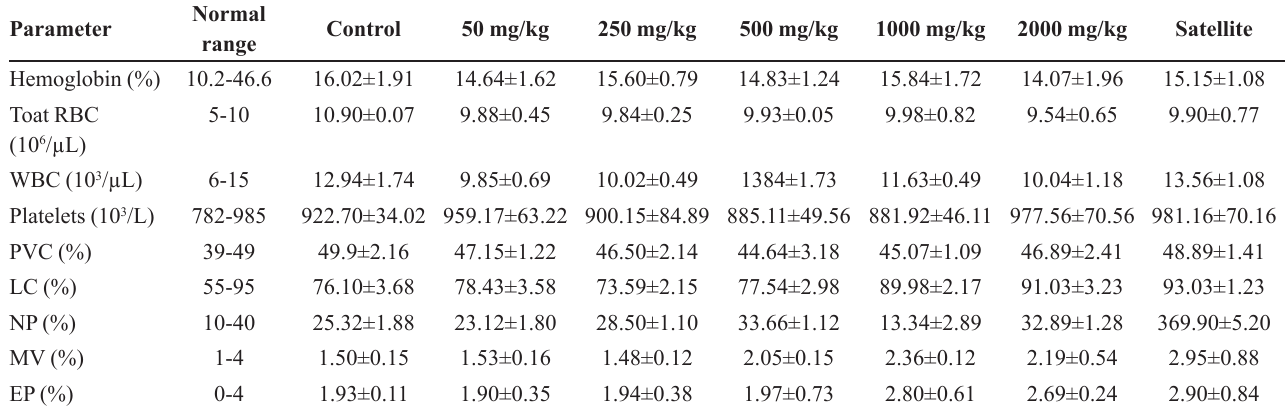
TABLE IV - Hematological parameters of rat treated with different dose level of AERI in sub-acute toxicity after 28th day Normal Parameter